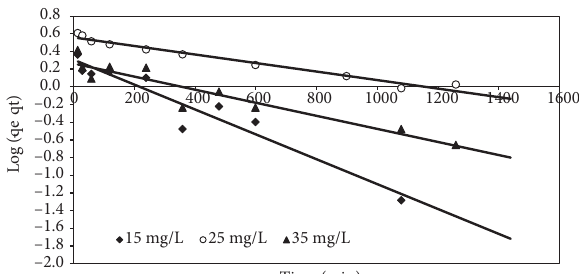
Fig. 7. Pseudo-first order kinetics of Cu 2+ adsorption onto the eggshell at various adsorbate amounts